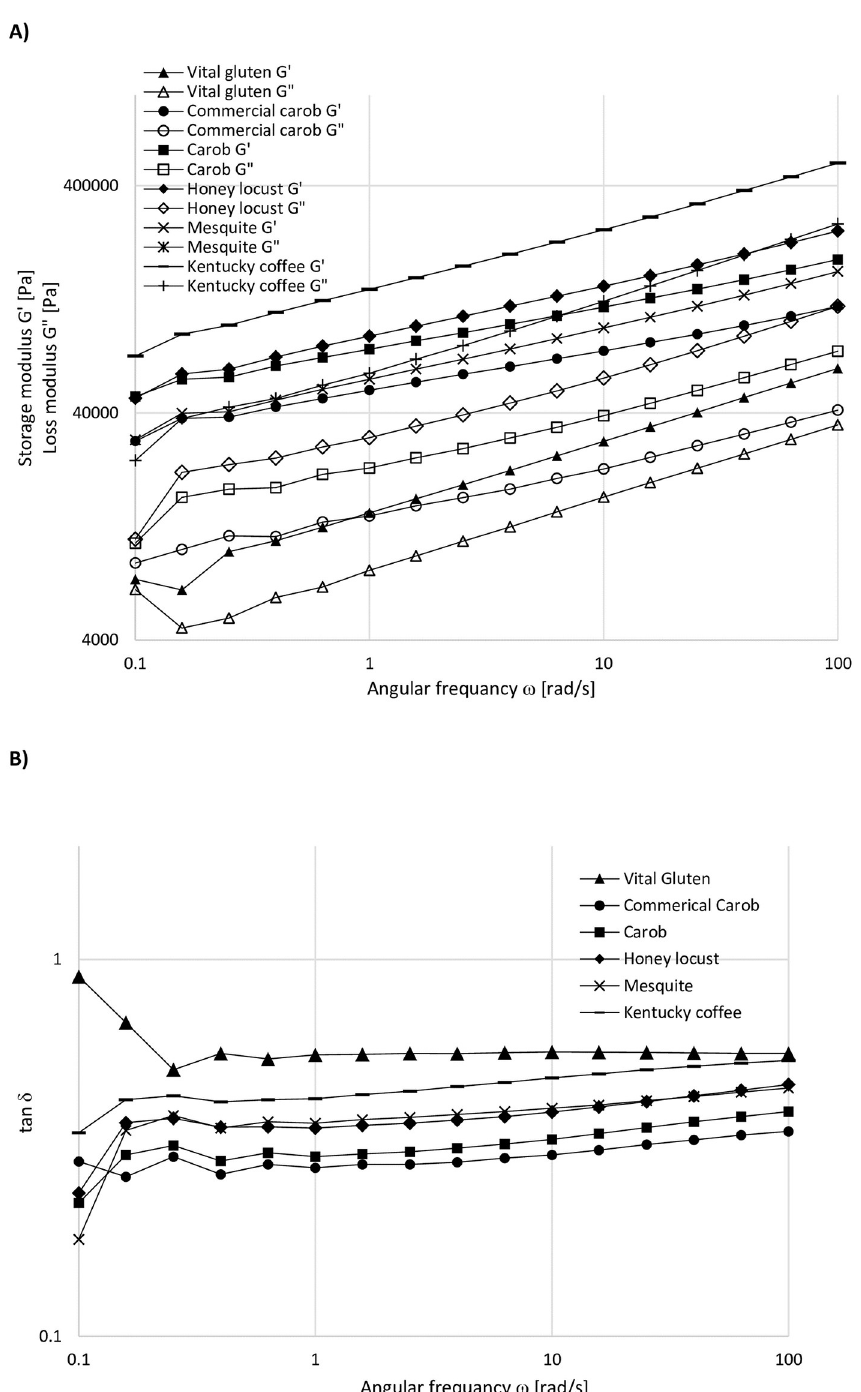
Fig 5. A) Frequency sweep data for the protein samples ( γ o = 0.02%, T = 20˚C), B) Loss factor (tan δ ) as a function of frequency for the protein samples.